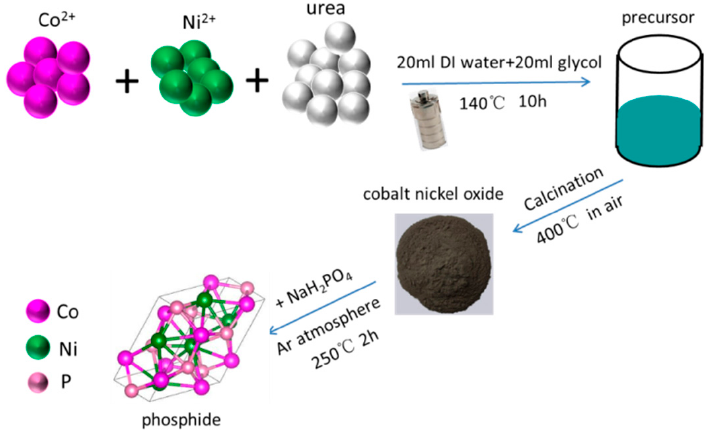
Figure 1. Schematic depiction of the synthesis process.